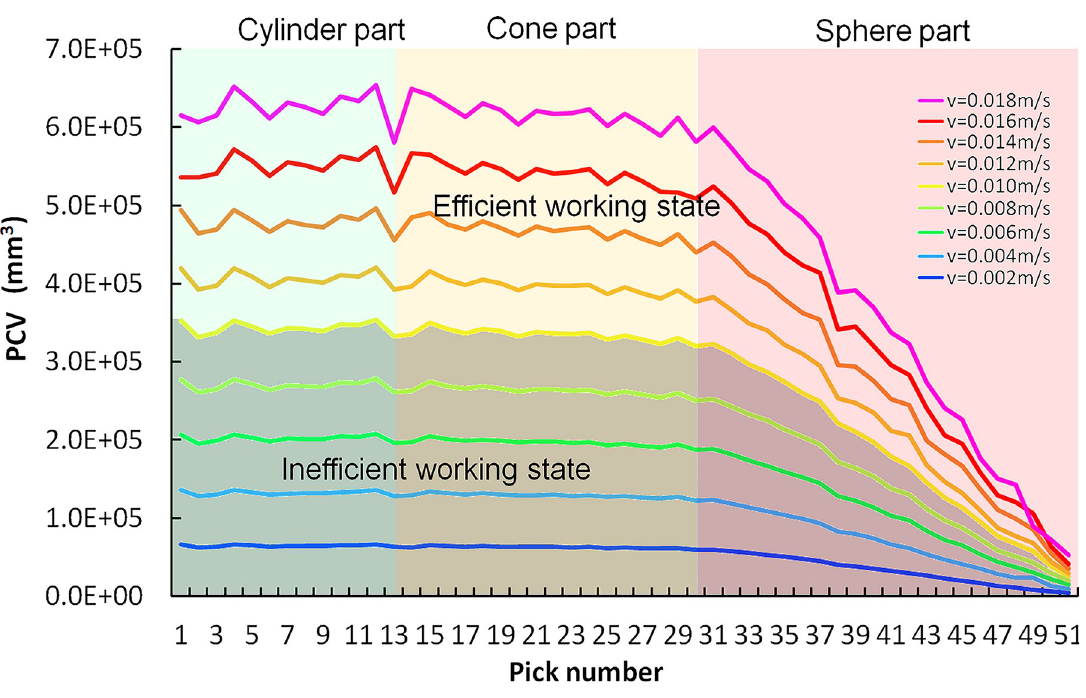
Fig 18. Cutting volume of each pick for one